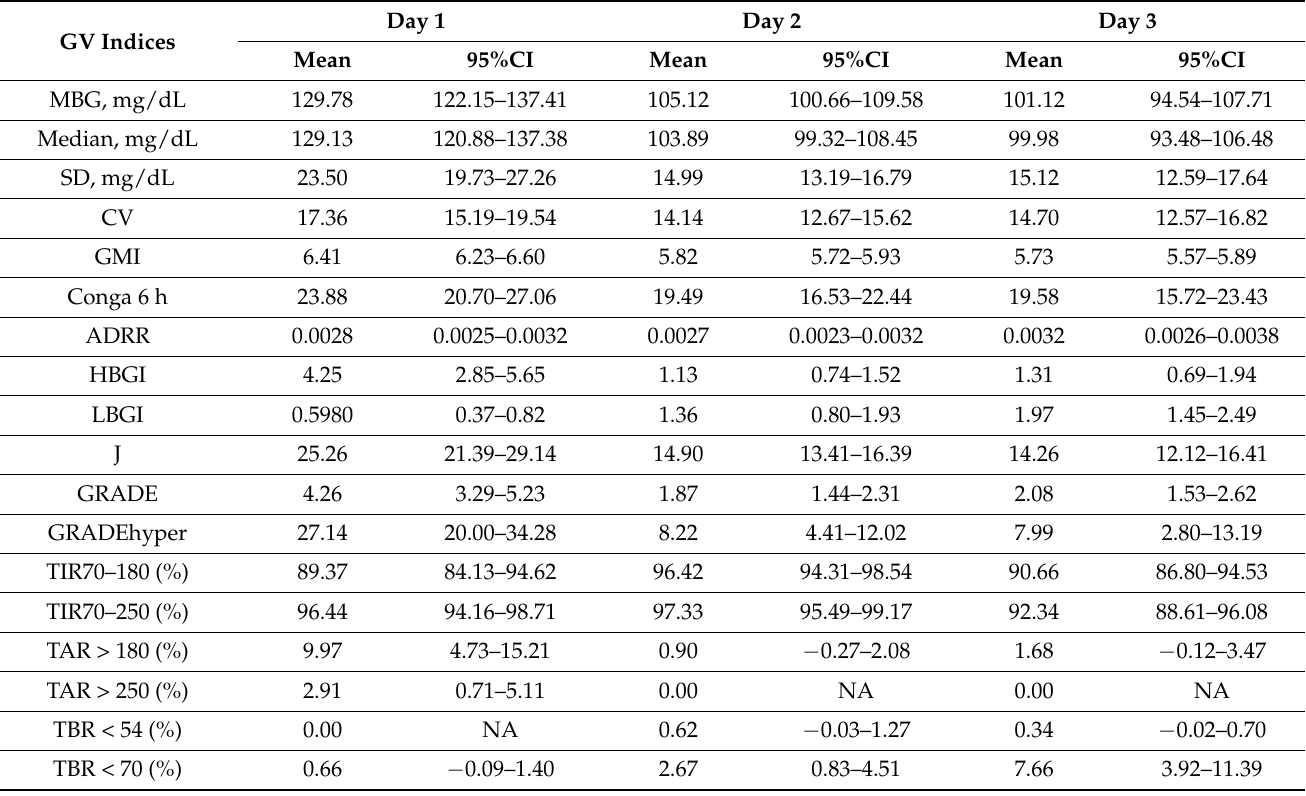
Table 2. Glucose variability (GV) indices for first 3 post-operative